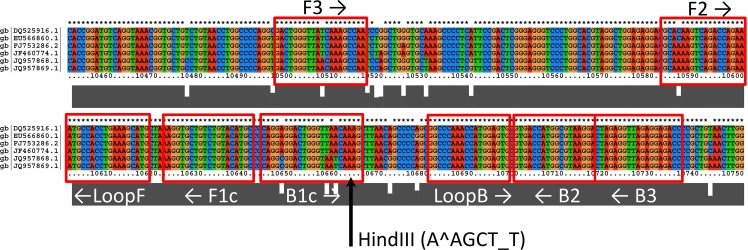
Sequence alignment showing priming regions for the SLEV 3’ UTR primer set.The arrow indicates the location of the HindIII restriction site.Genbank accession numbers refer to the following strains: DQ525916.1 = Kern 217; EU566860.1 = Hubbard; FJ753286.2 = CbaAr-4005; JF460774.1 = Imperial Valley; JQ957868.1 = Palenque-C475; JQ957869.1 = Palenque-A770.